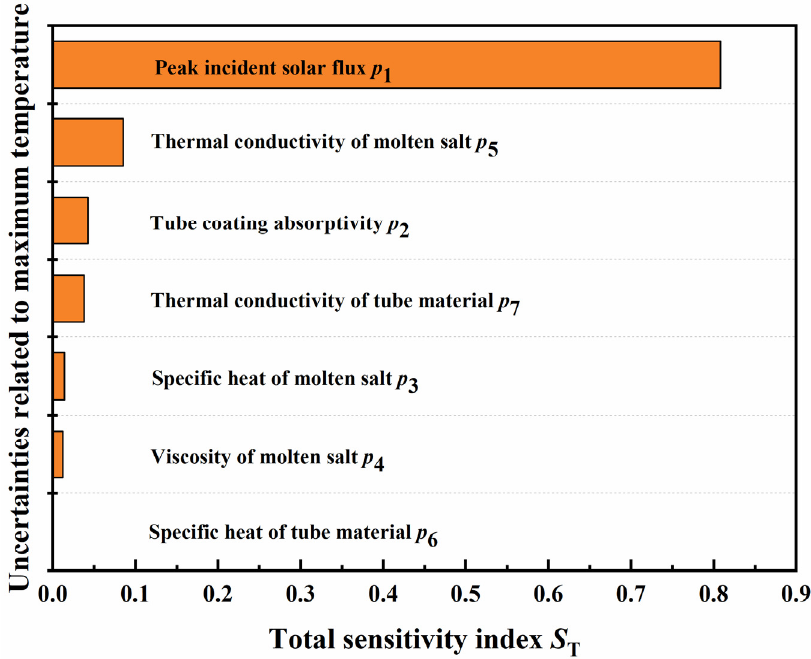
Figure 12. Sensitivity analysis results of the maximum temperature inside the tube wall.